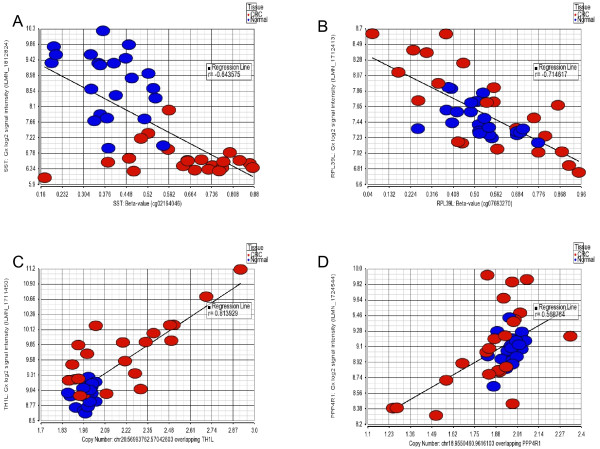
Correlation of gene expression with methylation and copy number data. A and B: Examples of gene expression (y-axis) correlating to methylation (x-axis) with differential expression & methylation in CRC compared to normal (A) and without differential expression or methylation (B). C and D: examples of gene expression (y-axis) correlating to copy number (x-axis) with differential expression & CN change in CRC compared to normal (C) and without differential expression or CN change (D).